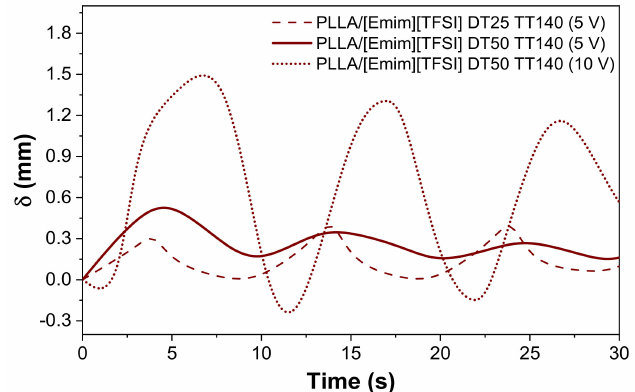
Figure 9. Displacement as a function of time for the PLLA / [Emim][TFSI]-DT25 and PLLA / [Emim][TFSI]-DT50 samples, subjected to a post-thermal treatment at 140 ◦